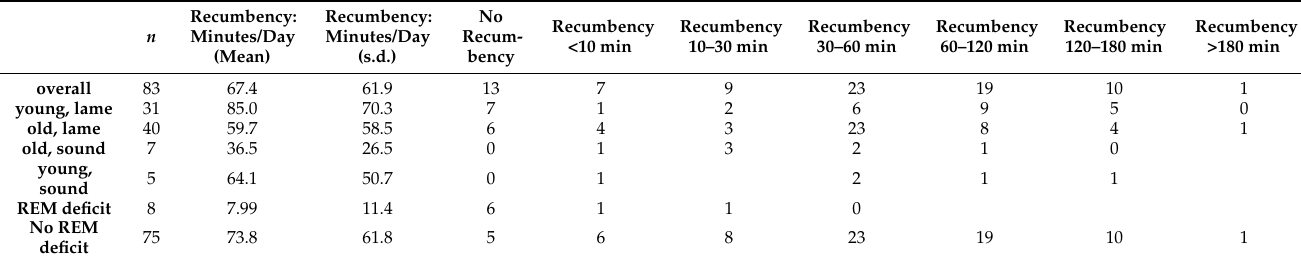
Table 1. The recumbency duration is detailed by group (young lame, old lame, old sound, young sound) and by the presence of REM deficit symptoms. In addition, the number of horses per recumbency duration period is listed.